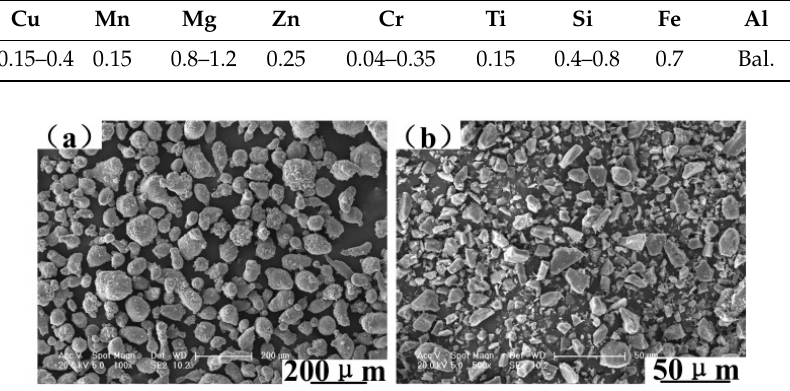
Figure 1. Morphologies of ( a ) 6061 aluminum alloy powder and ( b ) SiC powder.